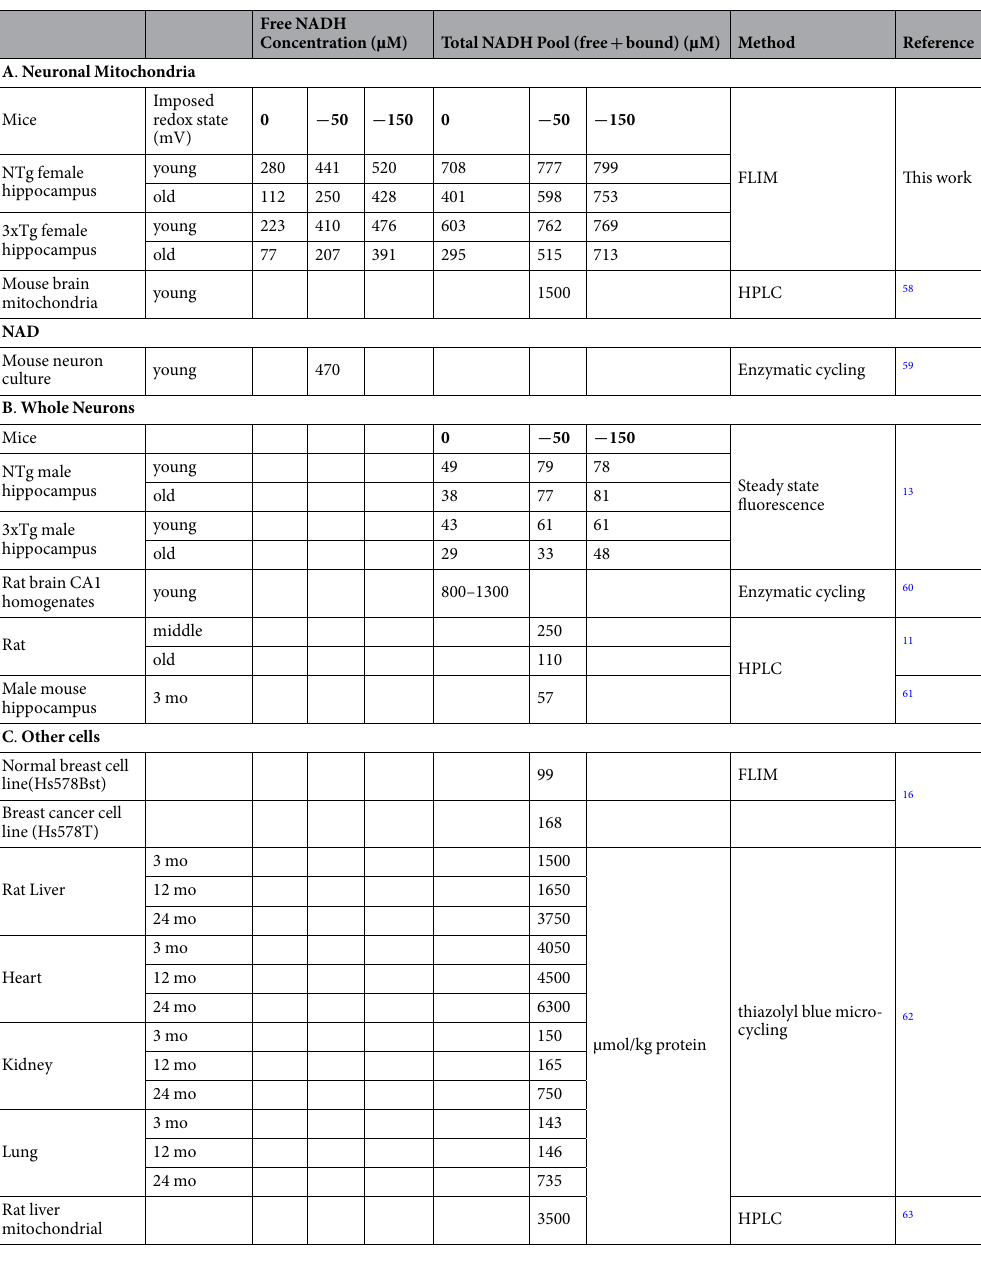
Table 1. Cellular NADH